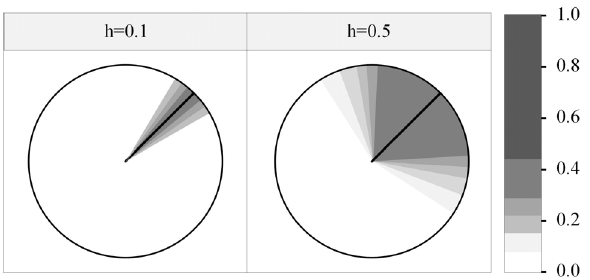
Figure 5. The representation of a directionally weighted kernel function in the sample space [35] .